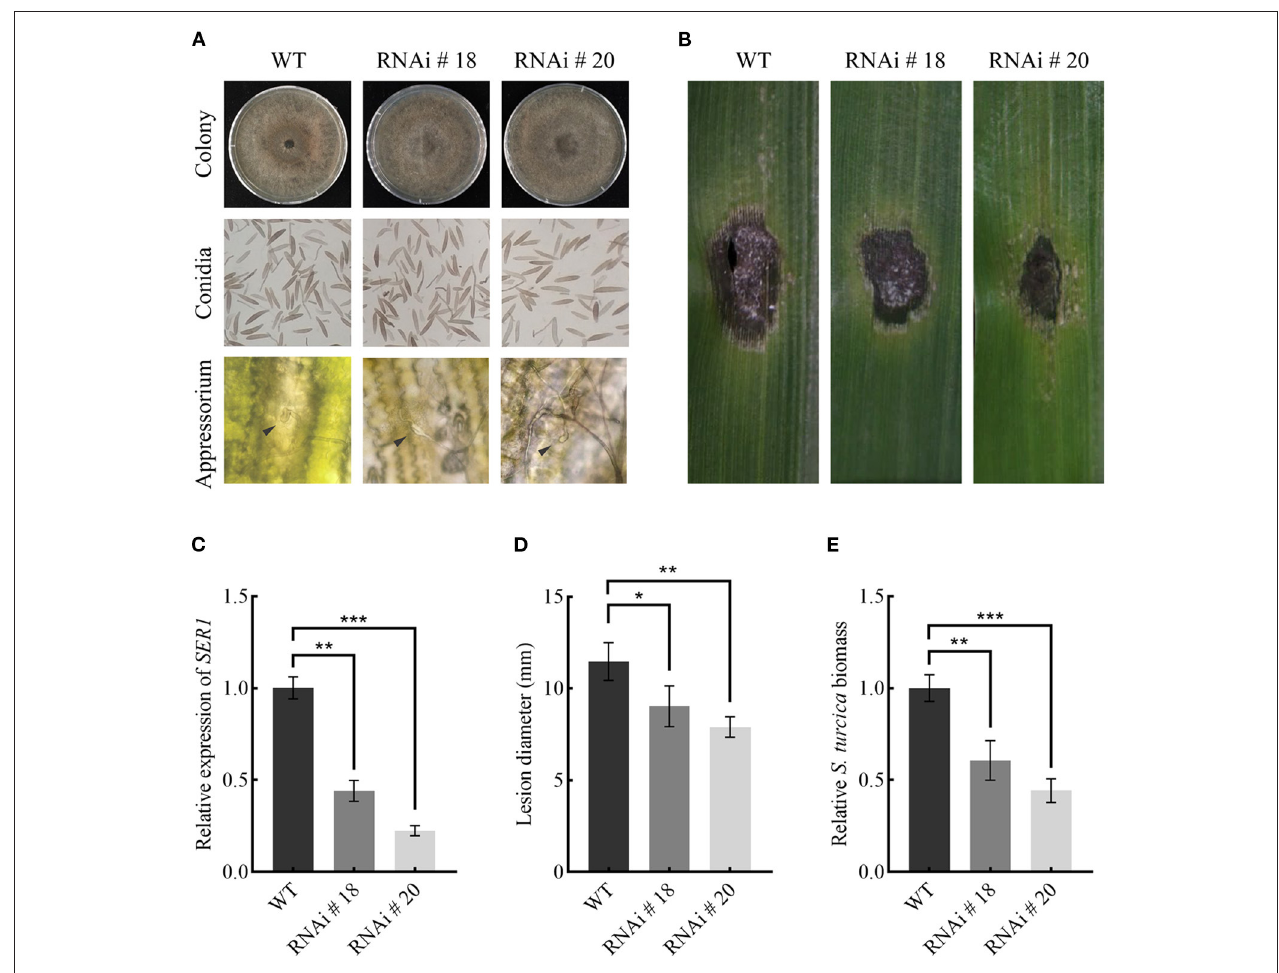
FIGURE 8 | SRE1 contributes to the virulence of S. turcica. (A) Comparison of colony, conidia, and appressorium morphology between wild-type TL-5 and silent transformants RNAi#18 and RNAi#20. The black arrow in the picture points to the newly-formed appressorium. (B) Pathogenicity assays to investigate the role of SRE1 gene silencing transformants RNAi#18 and RNAi#20 in the virulence of maize B73. The photograph was taken at 5 dpi. (C) The qPCR results showed the relative transcript levels of SRE1 in SRE1 -silenced transformants. Average lesion diameters (D) and relative S. turcica biomass (E) were calculated from three independent experiments and the error bars indicate standard deviations (* P < 0.05, ** P < 0.01, *** P < 0.001, Student’s t